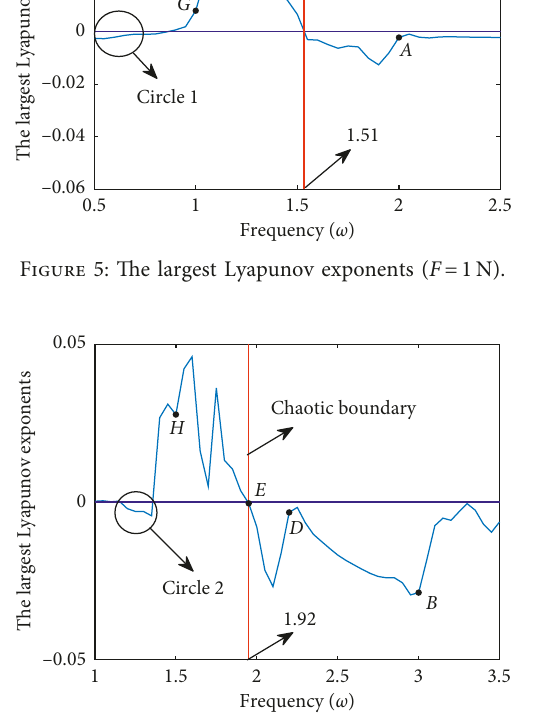
Figure 6: The largest Lyapunov exponents ( F � 1.5N).